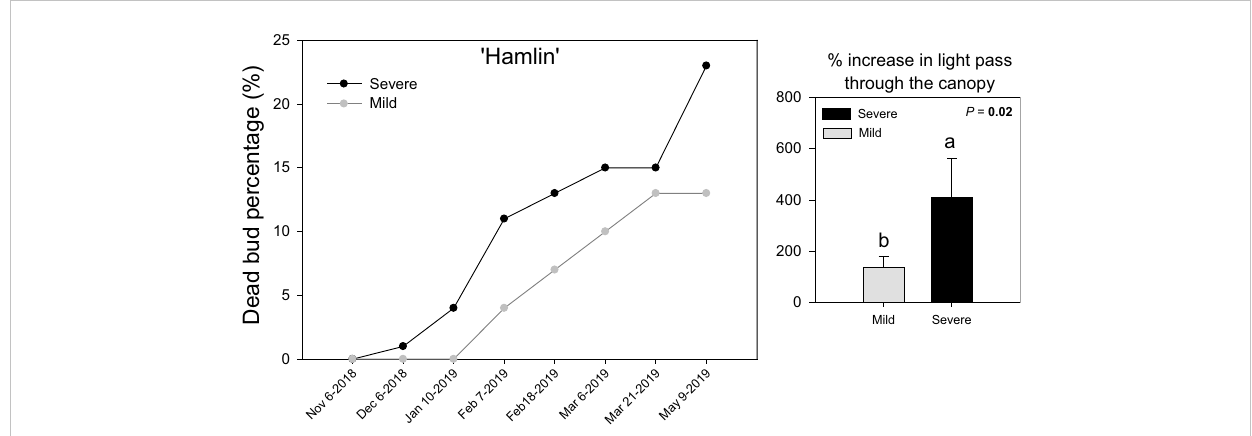
FIGURE 1 Dead bud percentage (%) on individual survey days and % increase in light penetrating through the canopy (PPFD, µmole/m 2 s) at the end of the experiment in Huanglongbing (HLB)-affected ‘ Hamlin ’ sweet orange trees with severe and mild symptoms, respectively. Each point is the mean ± standard deviation of four biological replicates. Signi fi cant differences were considered when P < 0.05 using Tukey ’ s honestly signi fi cant difference (HSD) test. Different letters indicate signi fi cant differences in the canopy density between severe and mild